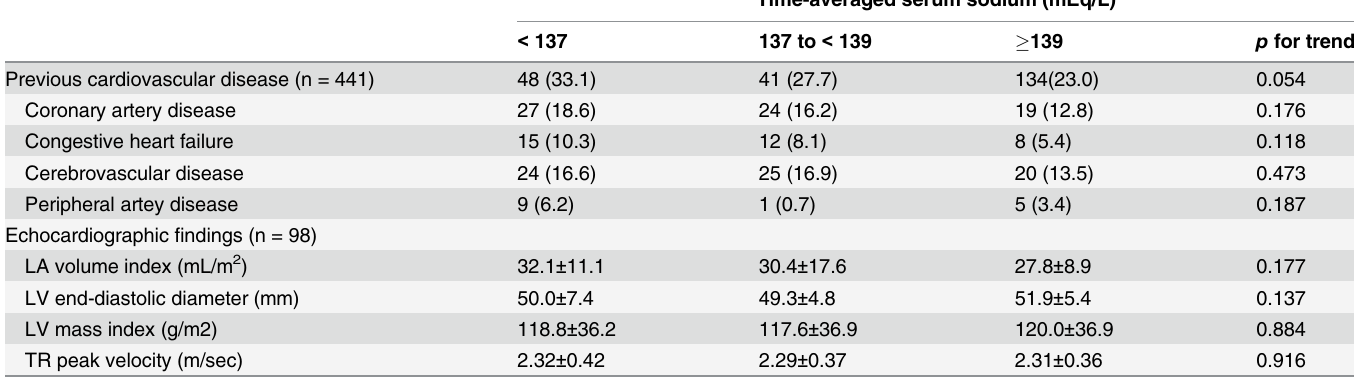
Table 1. Patient characteristics at